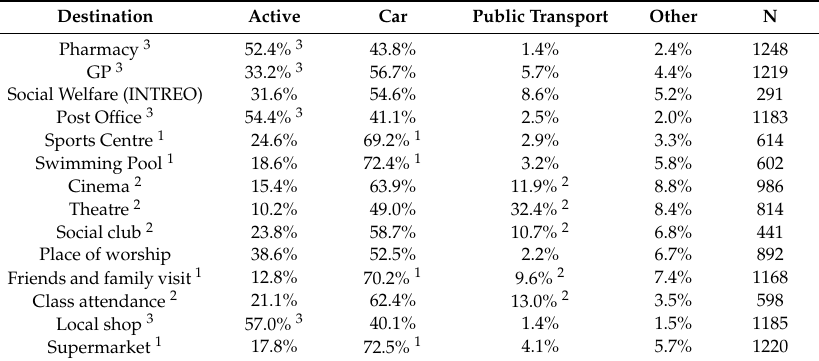
Table 5. Mode Split by Journey Purpose: Non-Work